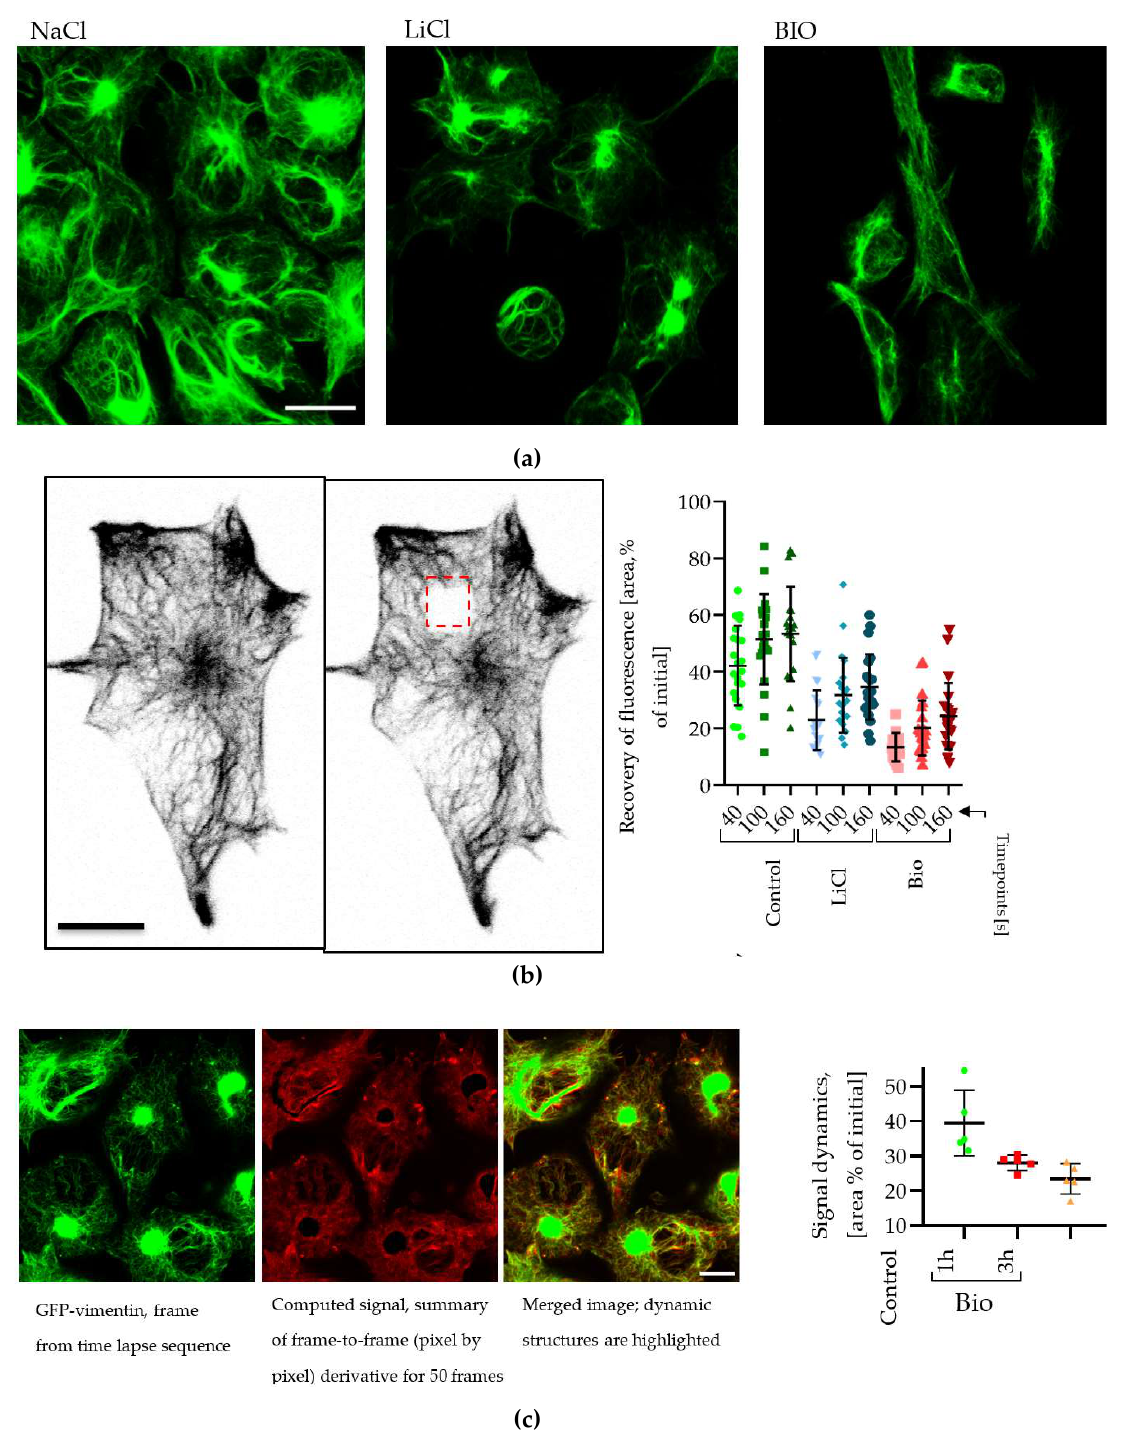
Figure 6. ( a ) Appearance of green fluorescent protein (GFP)-vimentin filaments after 20 mM LiCl or or 5 µ M BIO treatment (3 h, scale bar = 10 µ m). ( b ) Recovery of photo-bleached GFP-vimentin in 5 μM BIO treatment (3 h, scale bar = 10 μm). ( b ) Recovery of photo-bleached GFP-vimentin in time time points, scale bar = 10 µ m. ( c ) Quantification of dynamic of vimentin skeleton movement by points, scale bar = 10 μm. ( c ) Quantification of dynamic of vimentin skeleton movement by frame-to- frame-to-frame derivative ( µ m 2 ) in 50 frames (200 s) time lapse series; scale = 10 µ frame derivative (μm 2 ) in 50 frames (200 s) time lapse series; scale = 10 μm.